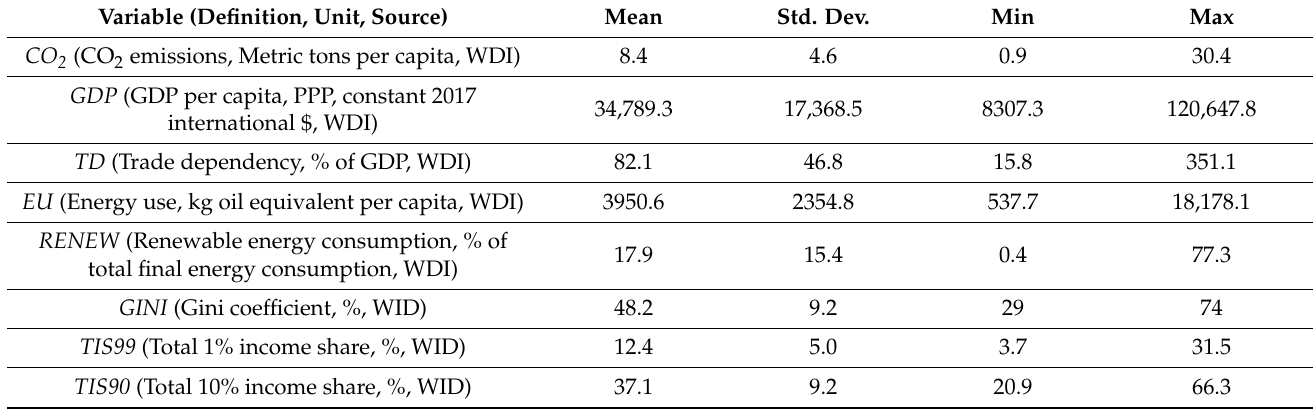
Table 1. Data descriptive, annual data (1990–2015, N = 988, n = 38, T =